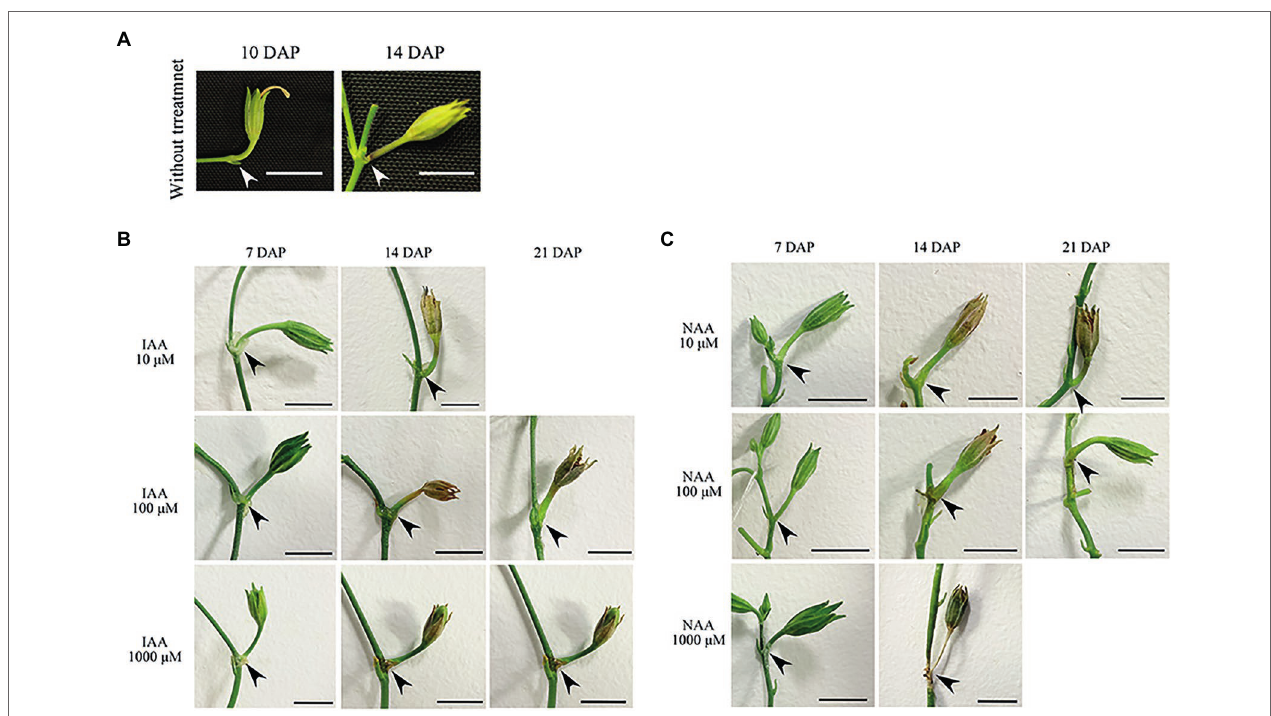
FIGURE 2 | Suppression of ovary abscission by auxin treatment in the cross Nicotiana suaveolens PI 555565 (8x) × Nicotiana tabacum . (A) Ovaries treated without lanolin paste. Enlarged ovaries dropped at 12–17 DAP. (B) Ovaries treated with IAA. (C) Ovaries treated with NAA. Arrowheads indicate the abscission zone at the intersection between the peduncle and branch. Scale bars = 1 cm. DAP, days after